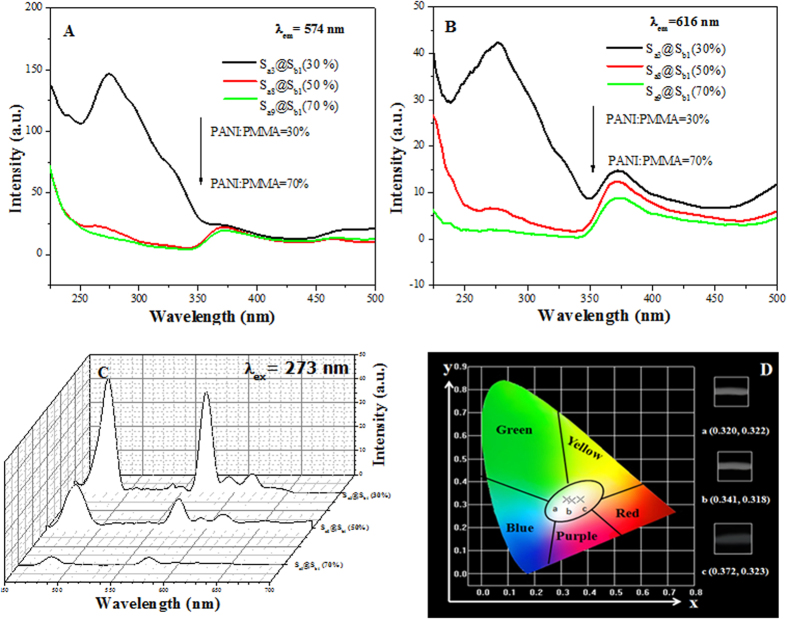
Excitation spectra (A,B), emission spectra (C) and CIE chromaticity coordinate diagram (D) of [Fe3O4/PMMA]@{[Dy(BA)3phen+Eu(BA)3phen]/PANI/PMMA} coaxial nanoribbons containing different mass percentages of PANI.